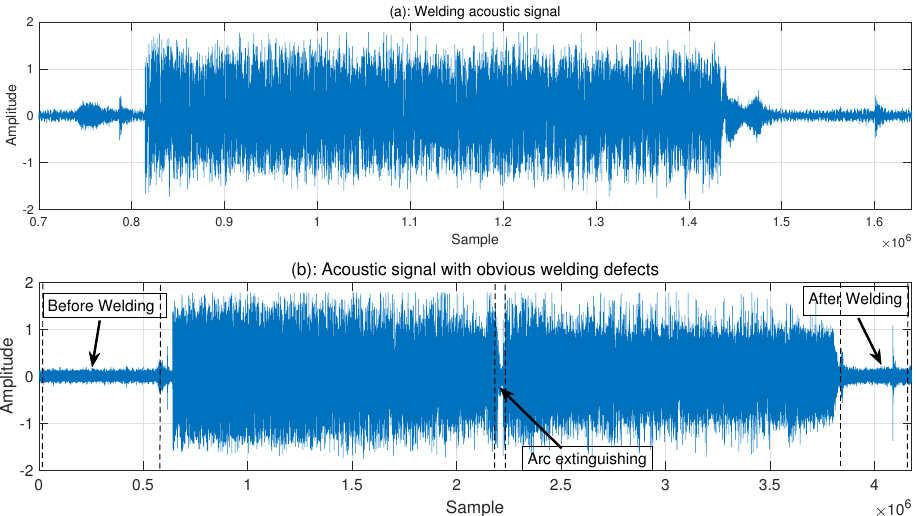
Figure 3. Welding acoustic signals: ( a ) signals with obvious welding defects; ( b ) signals without obvious welding